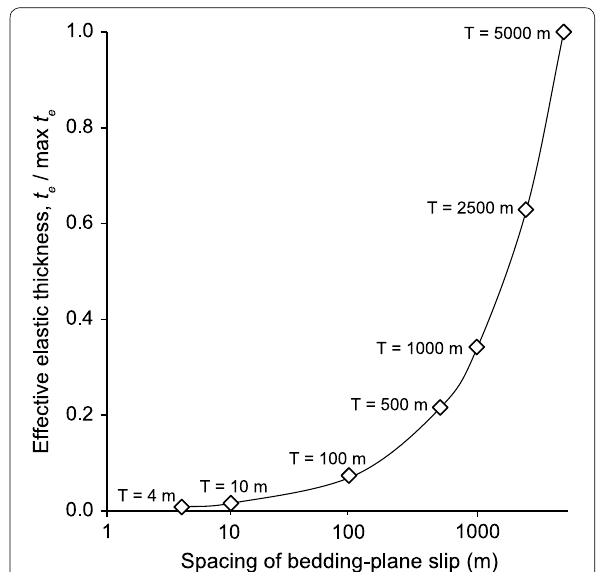
Fig. 5 Relationship between the effective elastic thickness and the spacing of bedding-plane slip surfaces. In the case of the maximum elastic thickness, the sedimentary mass contains no bedding-plane slip surfaces. In the sedimentary units, the numerous bedding-plane slip surfaces act to reduce the mechanical strength (effective elastic thickness) of sedimentary rocks under contractional deformation. T: Thickness of a bed as an elastic